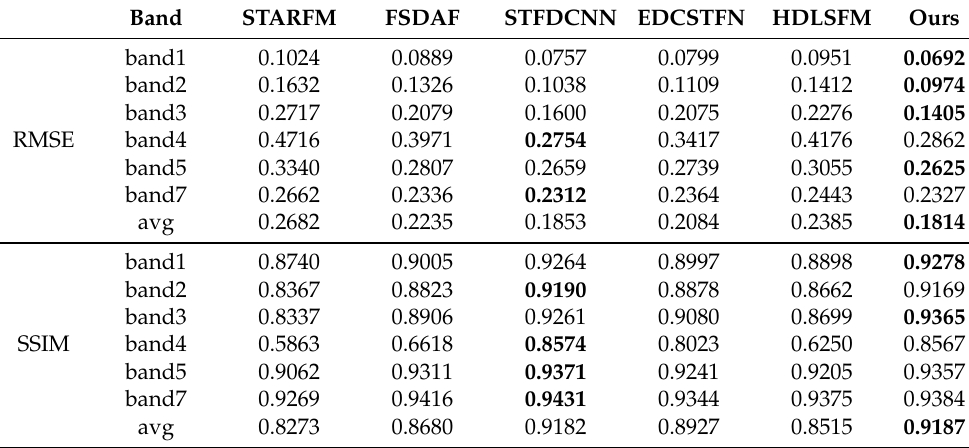
Table 3. Evaluation metrics of CIA prediction results. Bold values indicate the best